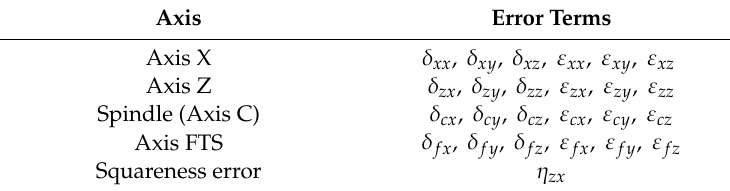
Table 1. Geometric error components of the fast tool serve (FTS) turning